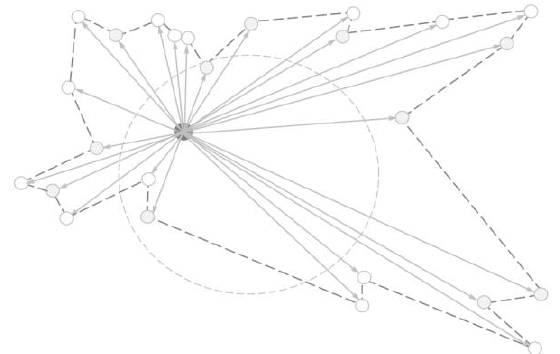
Fig. 1. A ecosphere with irregular, indistinct and non-simple boundary. An all-interconnected ecosphere with complex multiple physical, physiological, psychological and social